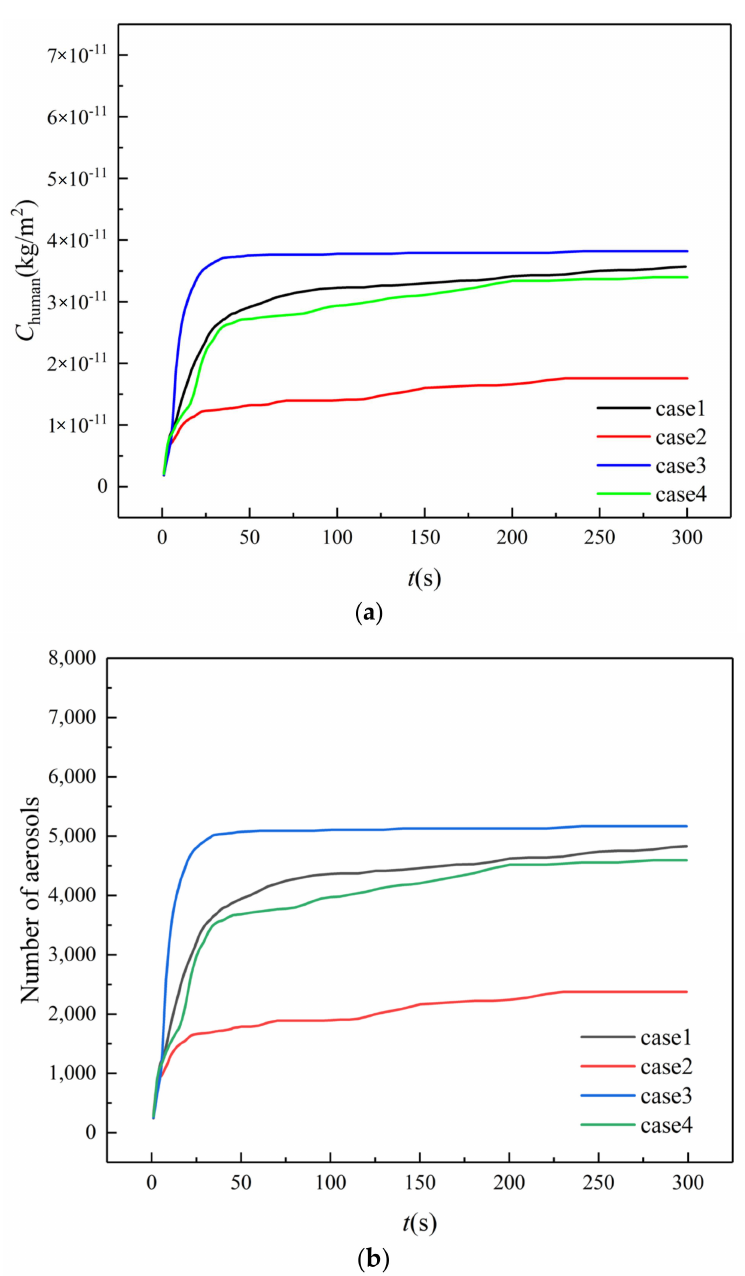
Figure 10. Aerosols on all human body surfaces. ( a ) Cumulative concentration; ( b ) Numbers. The cumulative concentration of aerosols on the walls, floor, and ceiling ( C walls ) in the farmers’ market is summarized in Figure 11. Different from the stalls and human body surfaces, the highest cumulative concentration of aerosols on the wall, floor, and ceiling is detected in case 1, which is about 2.21 times that of case 2. This is due to the slow update of indoor air in case 1. According to Figure 5, a large amount of aerosols from customer B gather near the ceiling at t = 20 s in case 1 and, hence, the increment of C walls is much faster than for the other cases after t = 20 s. On the other hand, the through flow in case 2 leads to a fast exhaust of aerosols from customer B and the risk of human infection in case 2 is relatively the lowest. Although there are four doors open in case 4, the flow rate at the back, left, and right doors in case 4 is lower than the flow rate at the back door in case 2. Moreover, the air distribution in case 4 is less uniform than case 2. Hence, the aerosols deposited on the walls, floor, and ceiling in case 4 are approximately the same as case